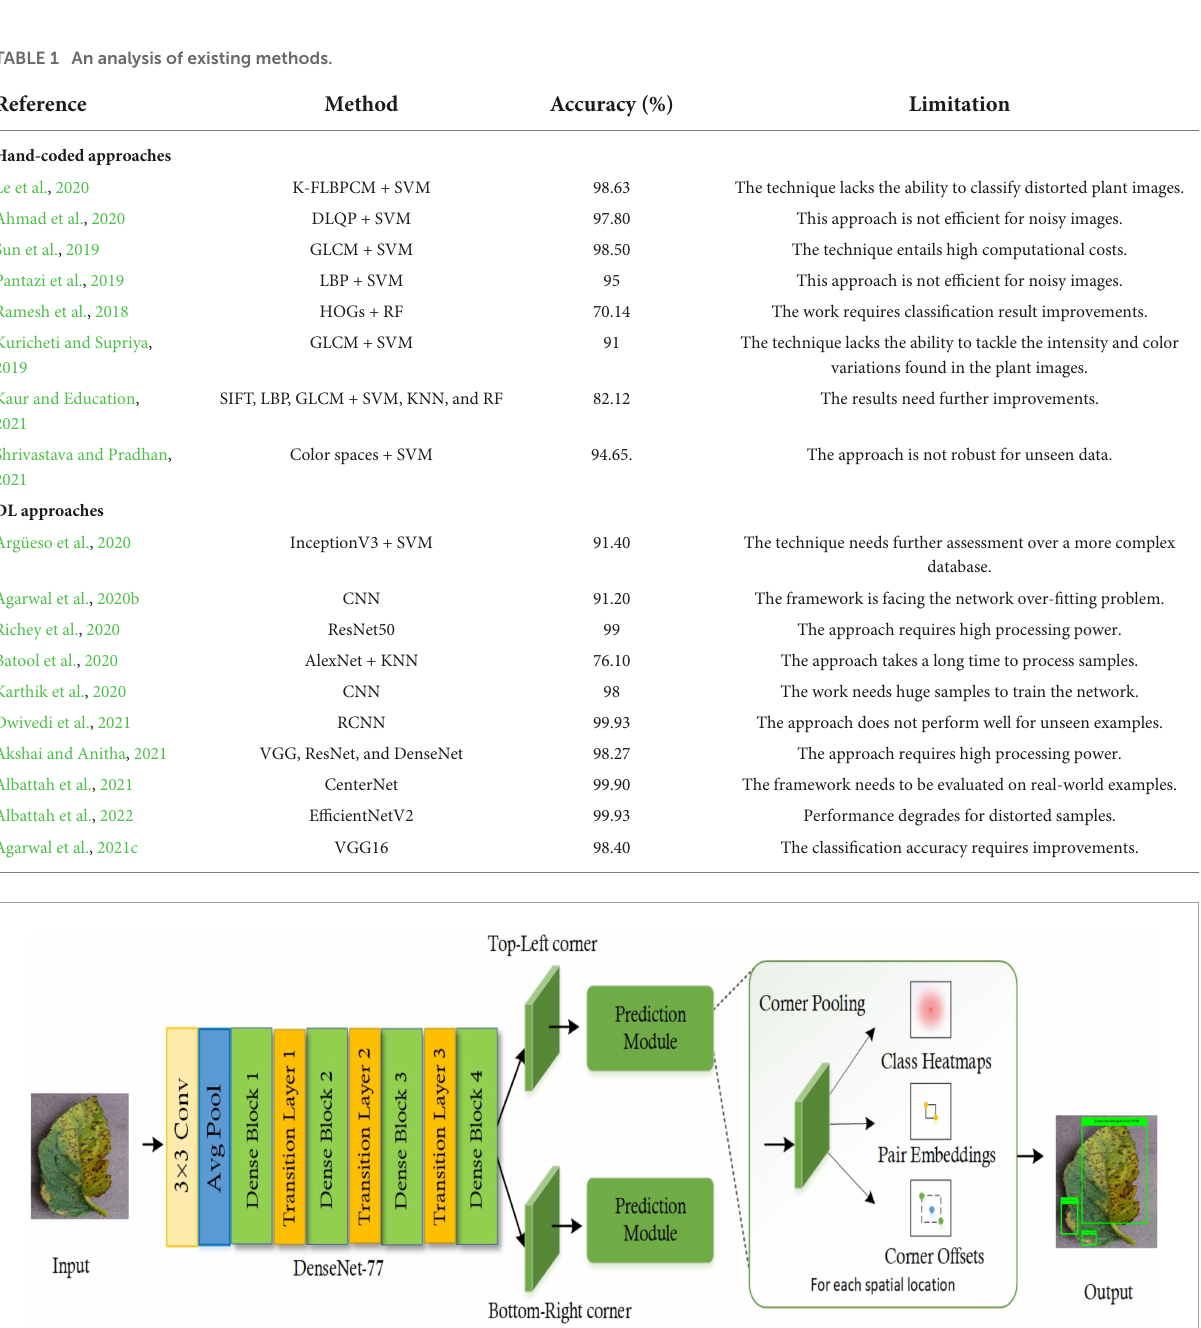
FIGURE1 Pictorial depiction of the DenseNet-77-based CornerNet model for the tomato plant leaf diseases